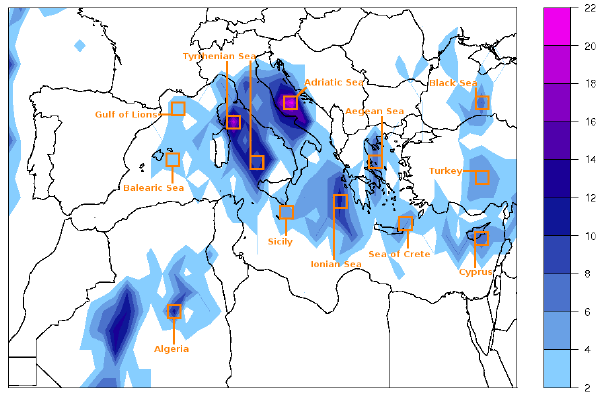
Fig. 1. Number of mature intense cyclones per square of 1 . 125 ◦ × 1 . 125 ◦ over the 45-yr ERA-40 period. The labels indicate the loca- tion of the 13 selected regional cyclone